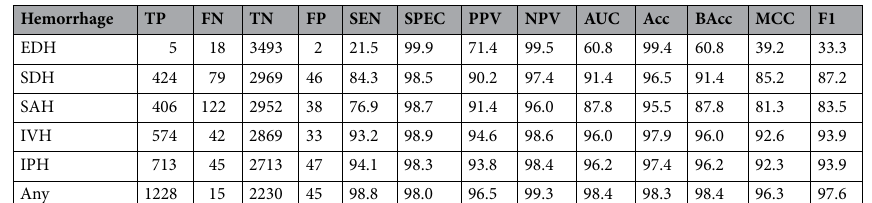
Table 2. ML performance in detecting ICH on the test set. TP true positive, FN false negative, TN true negative, FP false positive, SEN sensitivity, SPEC specificity, PPV positive predictive value, NPV negative